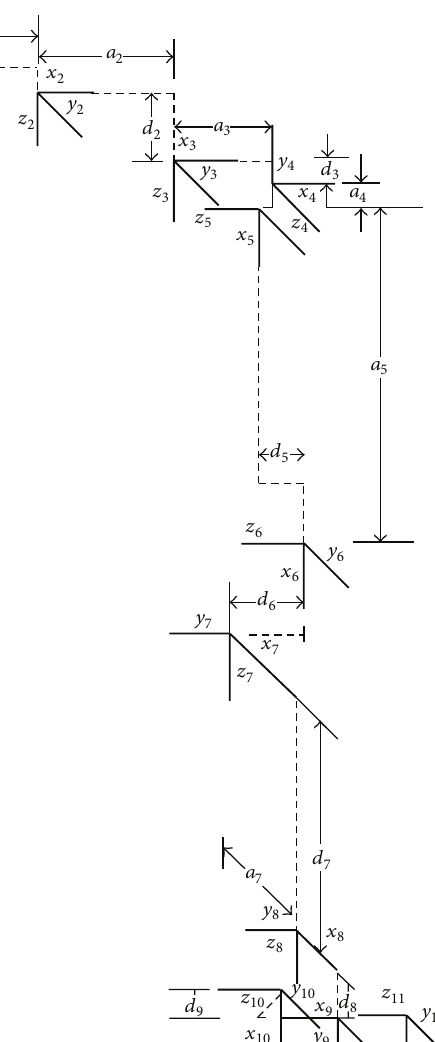
Figure 12: Coordinate system of 3D model.